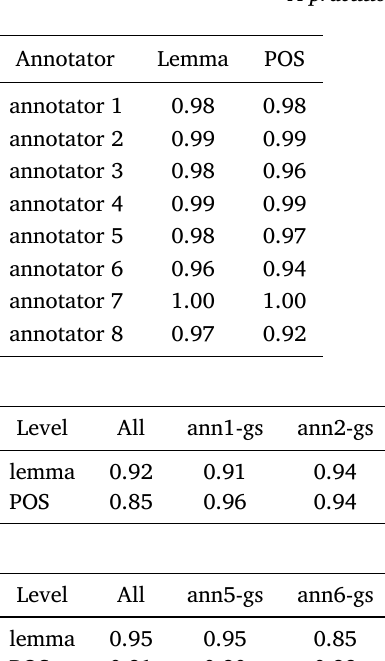
Inter-rater agreement: summary for the Mendel